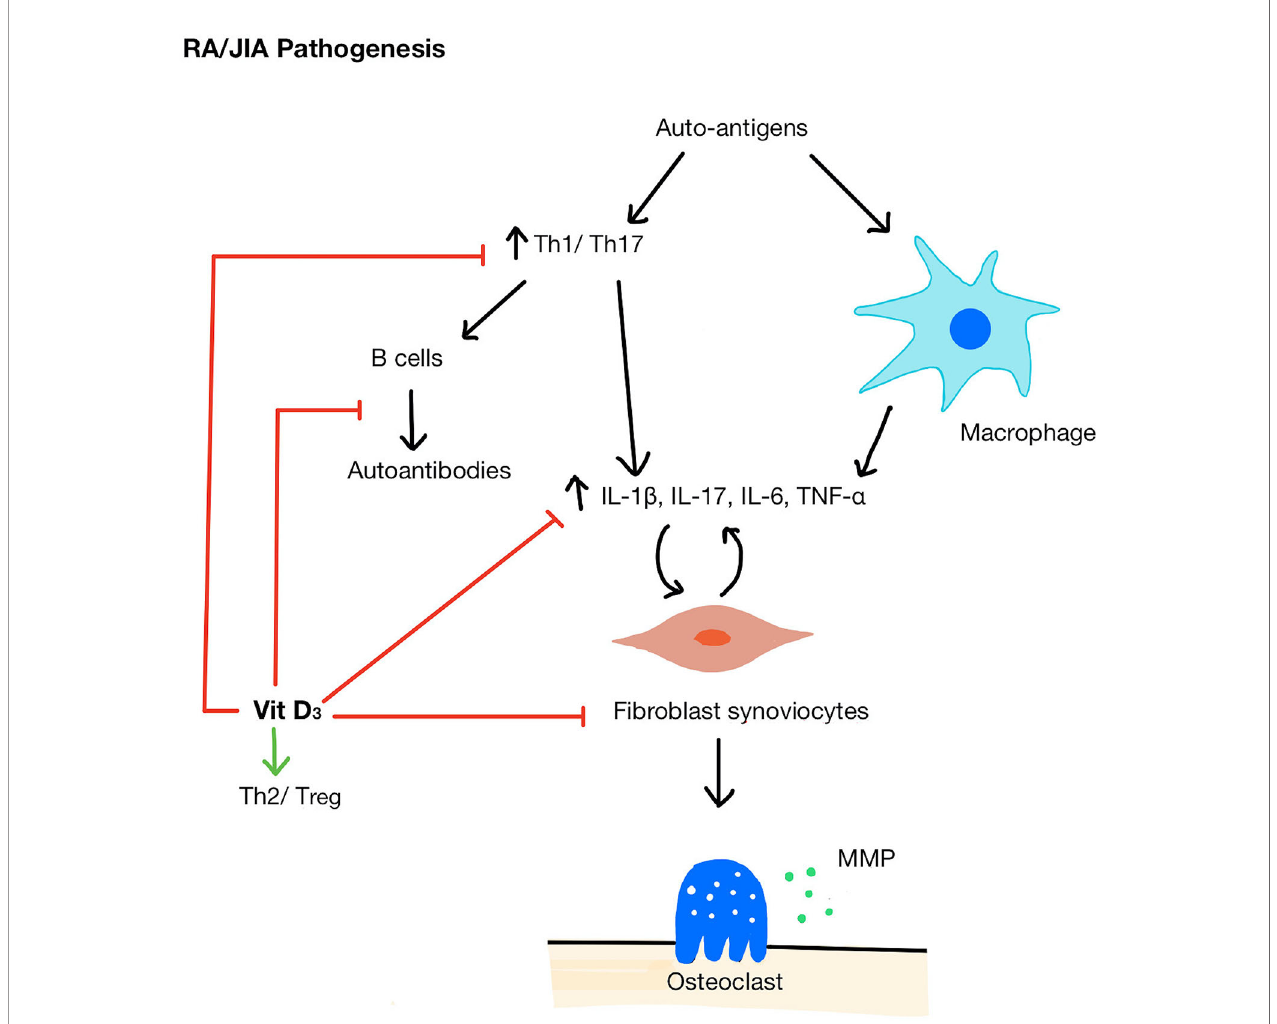
FIGURE 2 | Pathogenesis of RA/JIA and mechanisms of vitamin D acting on immune cells. A breakdown in tolerance in RA/JIA leads to increased Th1/Th17 cells and promotes macrophages to produce pro-in fl ammatory cytokines (IL-1 b , IL-17, IL-6, TNF- a ) which in turn stimulates fi broblast synoviocyte proliferation. Synoviocytes then activate osteoclasts and secrete MMPs which break down bone and cartilage. Vitamin D shifts the balance of Th cells from Th1/Th17 to Th2/T reg , inhibit B cells and autoantibody production, reduces pro-in fl ammatory cytokines, and inhibits synoviocyte proliferation. MMP, matrix